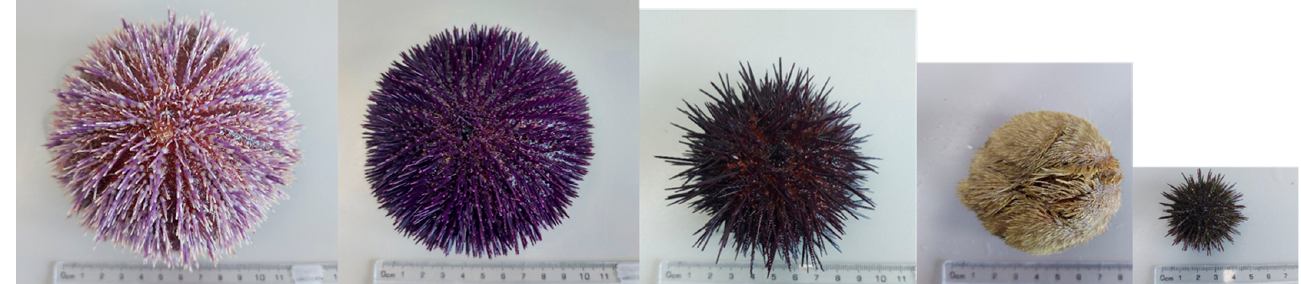
Figure 1. Sea urchin species, from left to right: Echinus esculentus, Sphaerechinus granularis, Paracentrotus lividus , Echinocardium cordatum and Psamechinus miliaris adults at scale. Sphaerechinus granularis (Lamarck, 1816) is also a regular sea urchin with a globose body diameter of up to 10–15 cm. It can be shaded purple or white, and their spines are